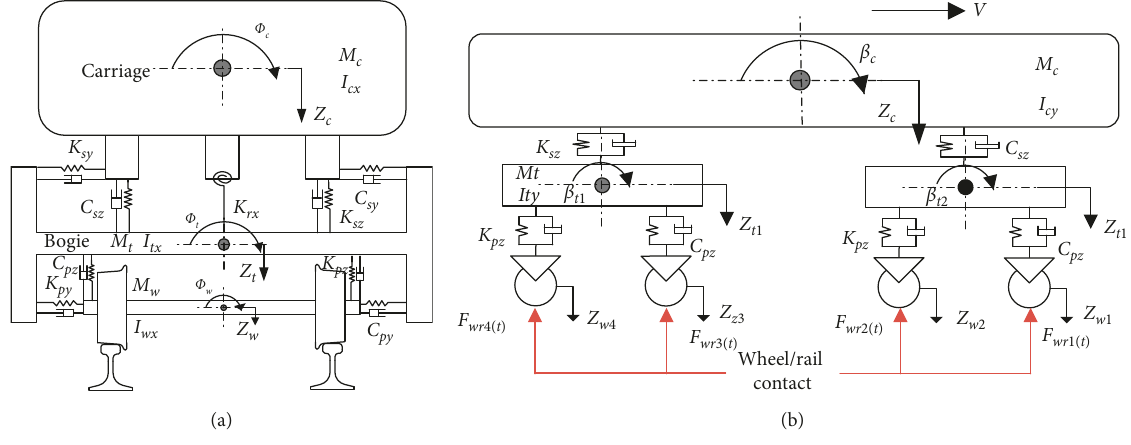
Figure 10: Schematic model of the vehicle: (a) front view; (b) side